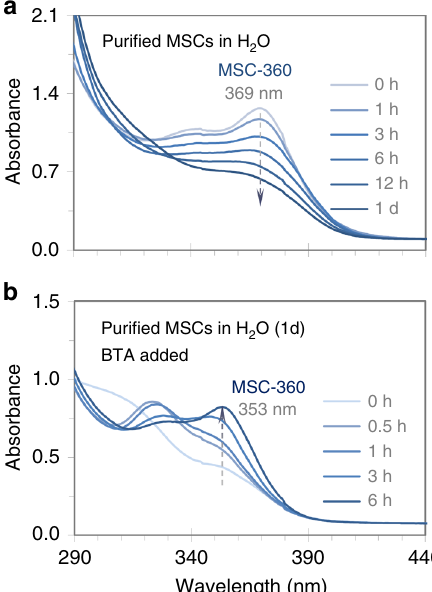
Fig. 5 Absorption spectra of an aqueous dispersion of puri fi ed CdS MSC- 360 before and after mixing with BTA. All spectra are offset to have similar absorbance at 440 nm. Puri fi ed CdS MSC-360 is dispersed in deionized water with a concentration of about 1.0 g ∙ L − 1 , and the absorption measurements last for 1 day at various durations indicated a . CdS MSC-360 disappears gradually. Afterwards, 1.5 mL of the dispersion is mixed with BTA (1.5 mL) for additional measurements up to 6 h b . CdS MSC-360 evolves again. In water ( a ), CdS MSC-360 transforms to its PC; upon the presence of BTA ( b ), the PC to MSC-360 transformation occurs, with almost complete recovery of MSC-360 in the relatively short period of 6